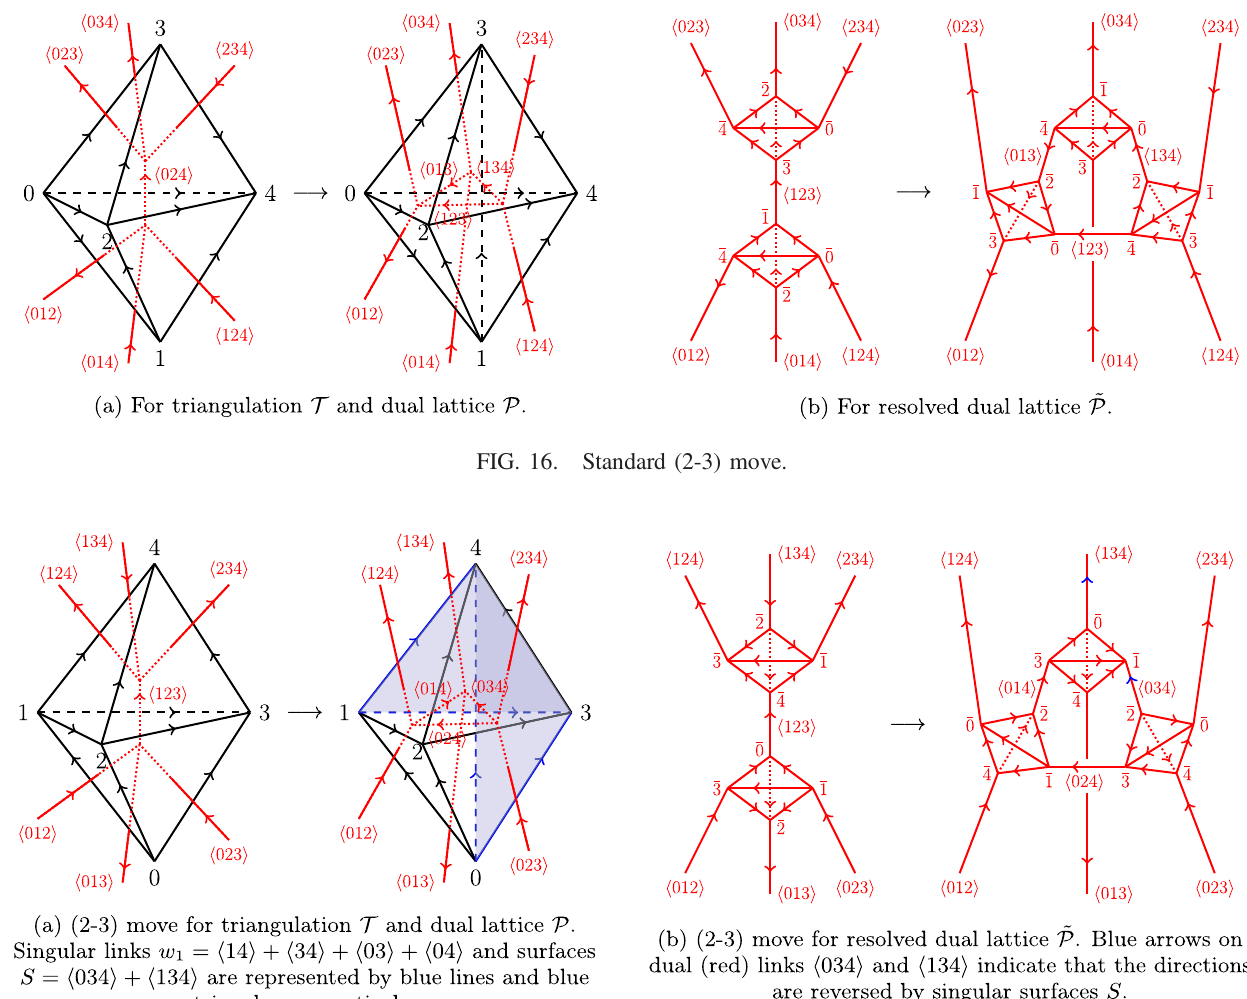
FIG. 17. A (2-3) move that involves singular